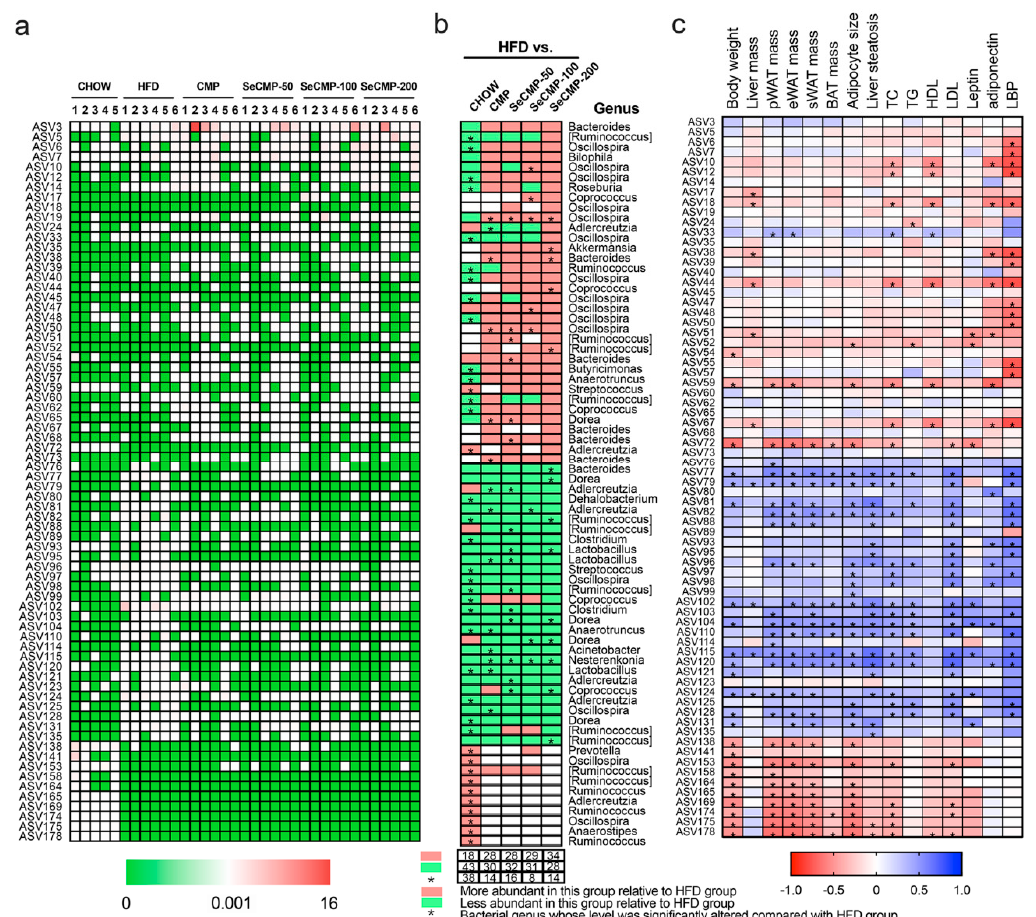
Figure 6. The relative abundance of specific amplicon sequence variants (ASV) identified at genus level and their association with obesity parameters affected by administration of selenium-rich C. militaris crude polysaccharides (SeCMP) and selenium-deficient C. militaris crude polysaccharides (CMP). ( a ) Heatmap of 72 identified bacterial genera affected by CHOW, HFD, CMP, SeCMP-50, SeCMP-100, and SeCMP-200 in comparison with the HFD group based on MetagenomeSeq analysis. ( b ) Bacterial genera from panel ( a ) and changes induced by the treatments. Red and green blocks indicated genera that were more or less abundant in the groups compared with the HFD group. Black stars indicated genera levels were significantly altered by HFD but reversed by treatments. ( c ) Correlation matrix between the identified ASVs and obesity traits using Pearson’s correlation analysis. * p < 0.05. CHOW: normal diet + sterile water; HFD: high-fat diet + sterile water; CMP: high-fat diet +100 mg/kg CMP; SeCMP-50: high-fat diet +50 mg/kg SeCMP; SeCMP-100: high-fat diet +100 mg/kg SeCMP; SeCMP-200: high-fat diet +200 mg/kg SeCMP.